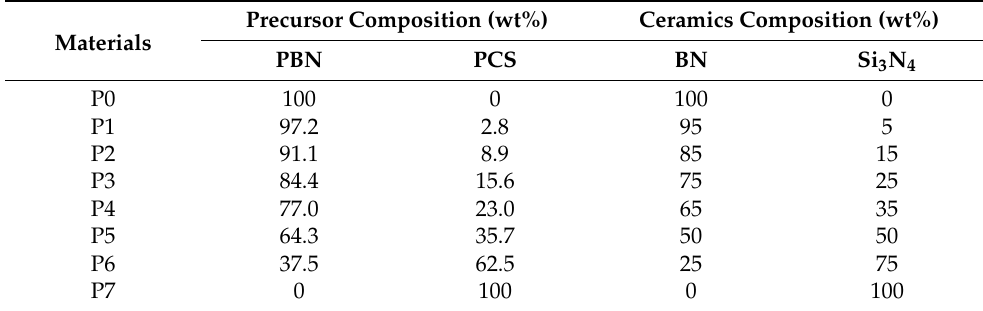
Table 1. Composition of hybrid PBN/PCS precursors and the BN/Si 3 N 4 ceramics derivatives (1600 ◦